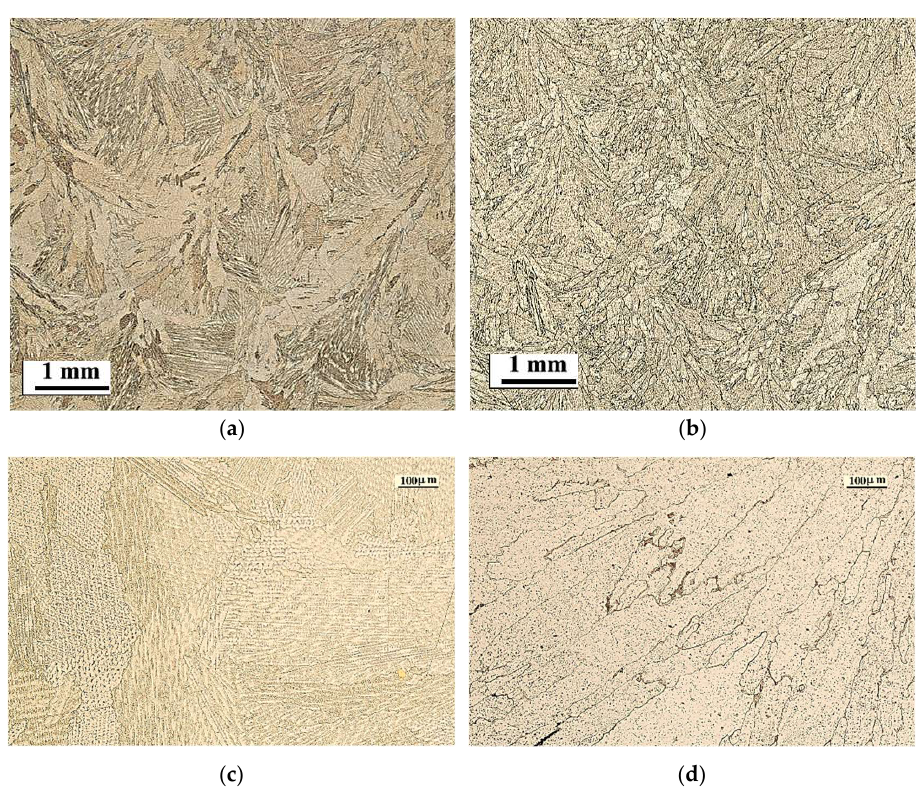
Figure 6. Cross-sections structure on the core: ( a , c ) as-deposited; ( b , d ) solubilization and aging (STA).